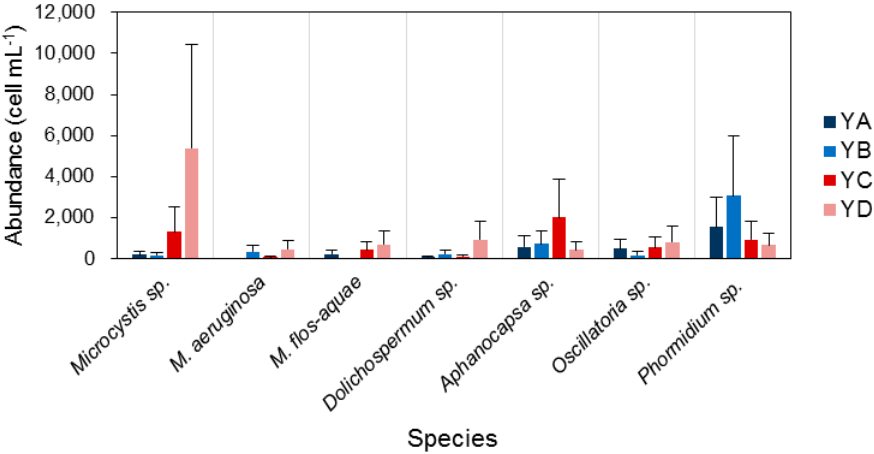
Figure 6. Variation in spatial abundance of the potentially toxic species in the upper part of the Youngsan River estuary. Bars in blue hues indicate upstream stations away from weirs (stations YA and YB), while red bars indicate stations near the weirs (stations YC and YD).